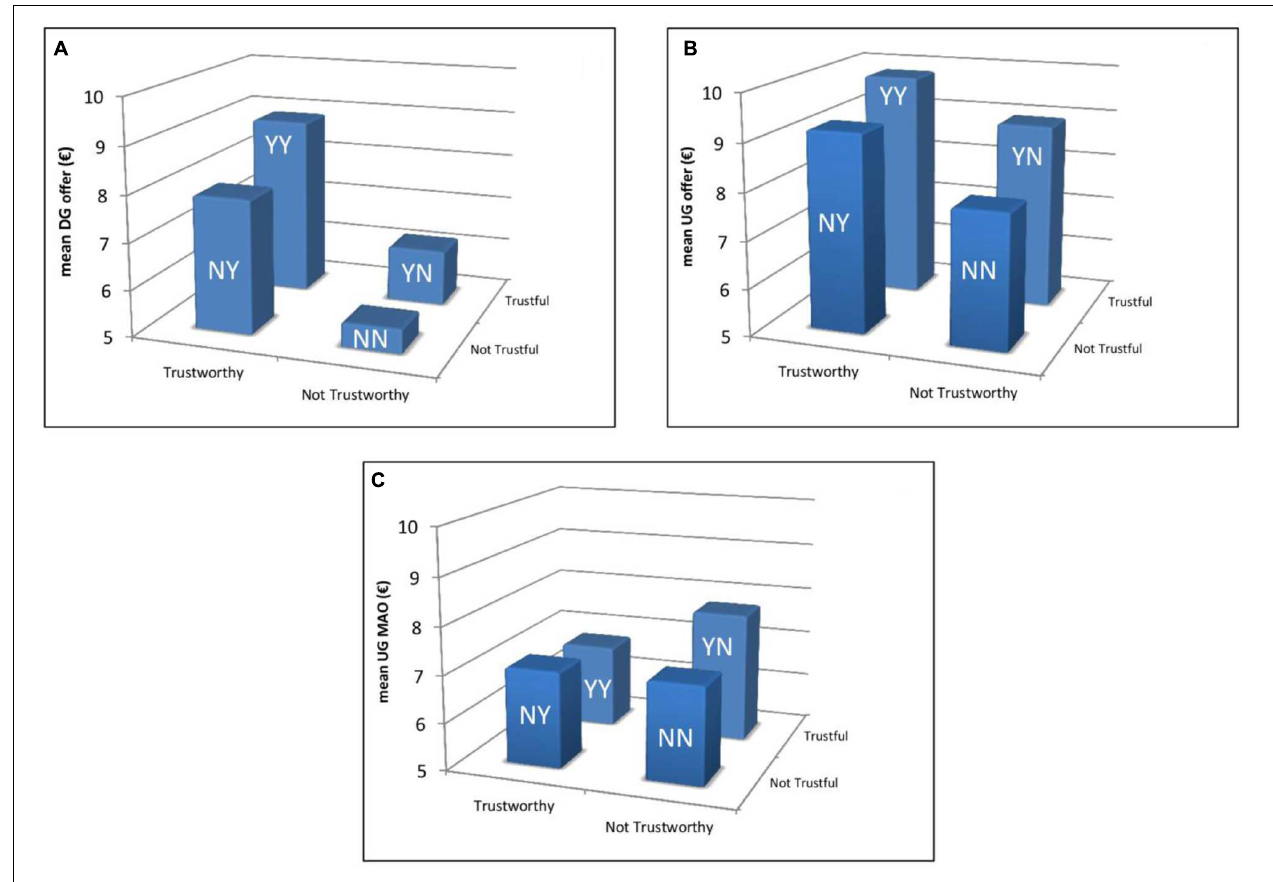
FIGURE 2 | Mean DG and UG behavior across TG groups. (A–C) Refer to DG offer, UG offer, and UG MAO, respectively. As can be seen in Figure 1B , the number of observations in each group are 439 in YY, 108 in YN, 112 in NY, and 115 in